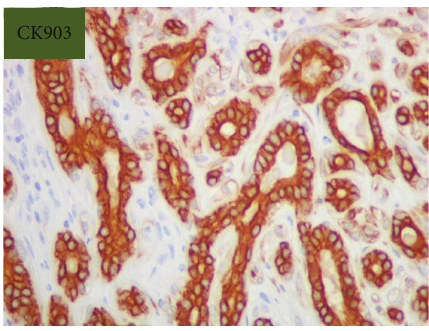
Figure 9: Epithelial stains, CK903 (original magnification × 400).